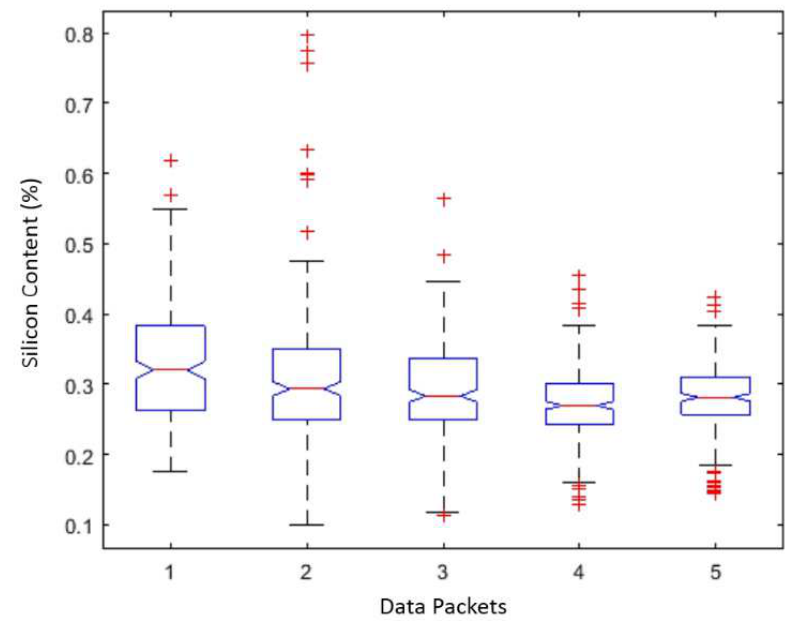
Figure 2. Box plot test of silicon content time series.